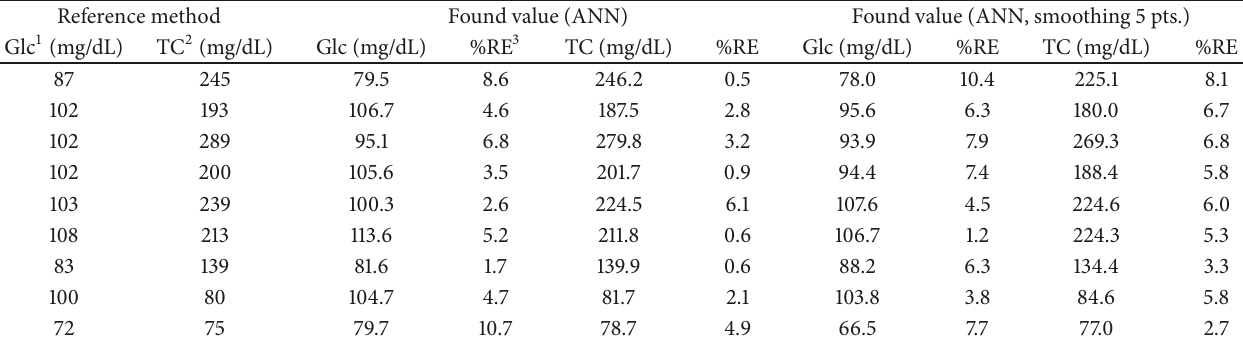
Table 6: Application of the ANN method for the estimation of glucose and cholesterol in serum